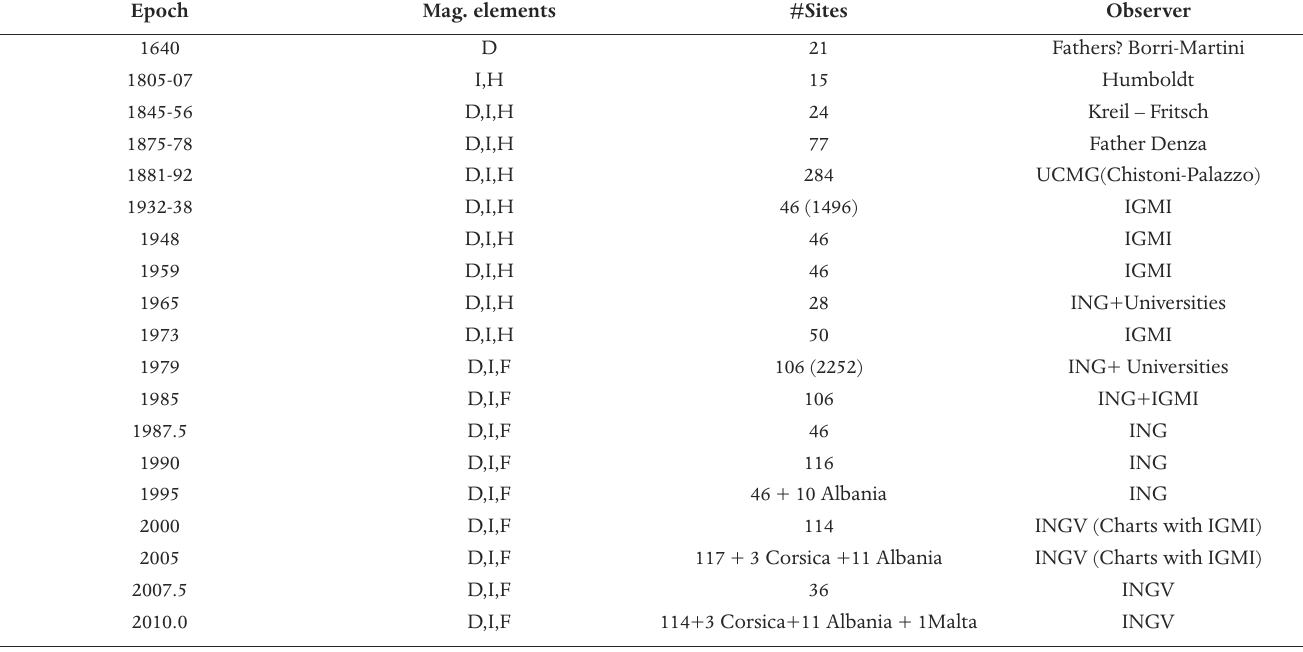
Table 1. History of magnetic surveys in Italy from 1640 to present. Acronyms are explained within the text. Additional acronym of UCMG stands for the